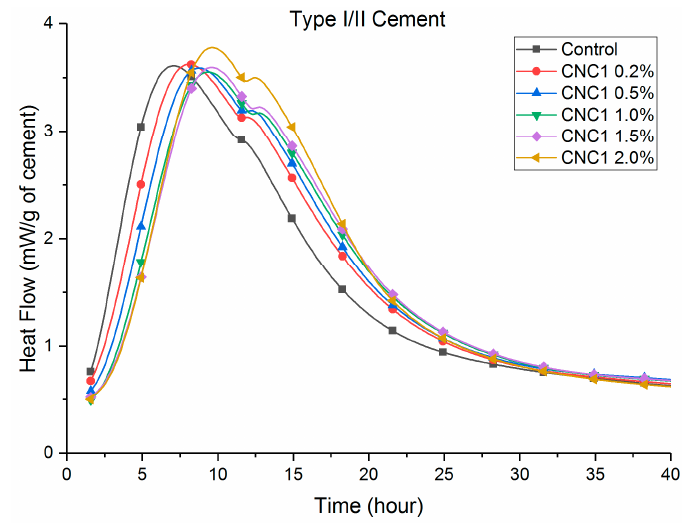
Figure 4. Heat flow of Type I/II cement, CNC1 at different dosages.